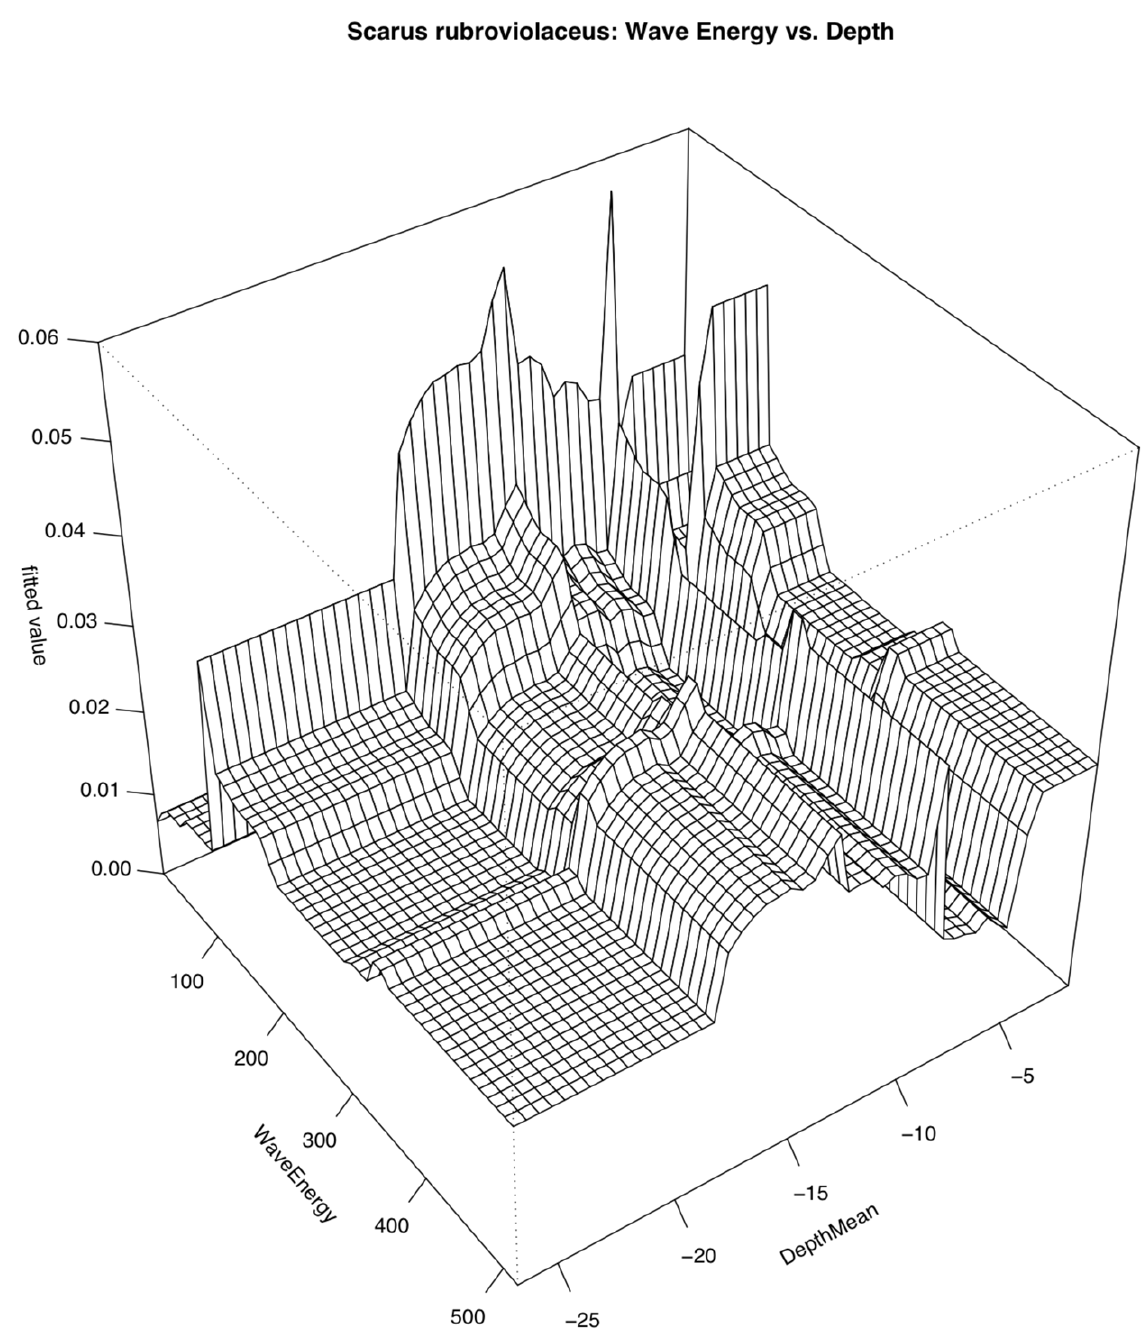
Figure 11. Pairwise interaction between depth and wave energy with respect to occurrence of Scarusrubroviolaceus . The effect of wave energy is influential only in depths shallower than 15 m. The effect of depth is somewhat magnified in lower wave energy areas.